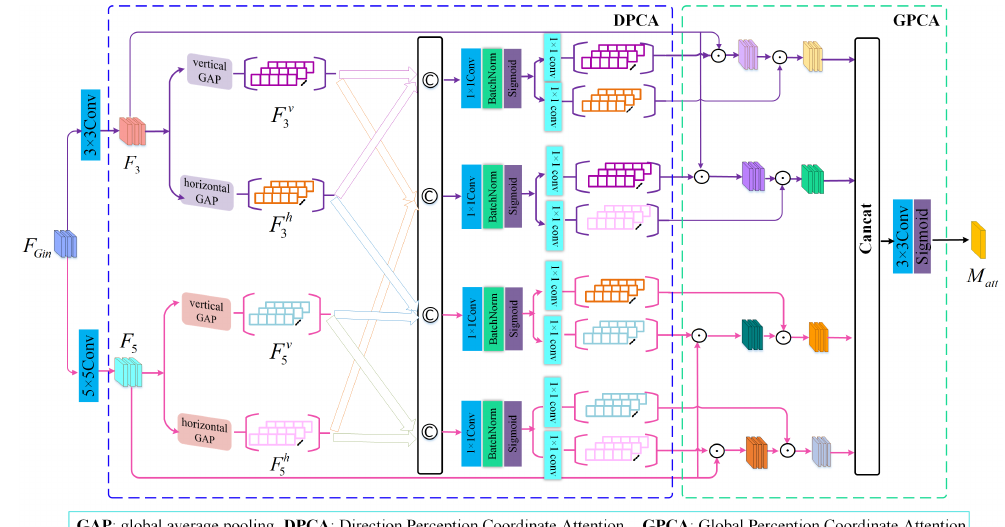
Figure 2. Dual-coordinate direction perception